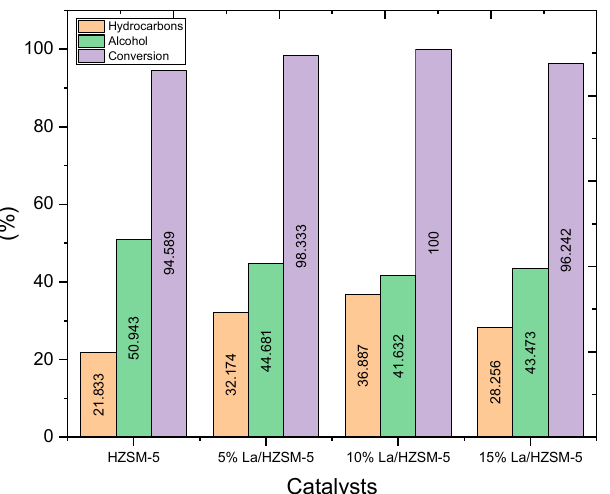
Figure 12. The conversion percentage of the algal HO and the yield percentages of the outstanding chemicals of the hydrocarbons and alcohol from the catalytic deoxygenation of the algal HO over the parent HZSM-5 zeolite and lanthanum-modified HZSM-5 zeolite with different loading-weight percentage (batch reactor, 300 ◦ C, 1000 rpm, 7 bar N 2 , the catalyst to algal HO = 15% (wt.%), and 6 h). In addition, the lowest yield of the produced hydrocarbons (21.83%), with the lowest conversion percentage (94.58%) of the algal HO in this study was over the parent HZSM-5. This might be due to prevailing amounts of other oxygenated compounds. For example, the decreased hydrocarbons generated by catalytic deoxygenation of algal HO over the parent HZSM-5 catalyst might be attributable to the predominant generation of alcohols, esters, aldehydes, ketones, and ethers (refer to Table